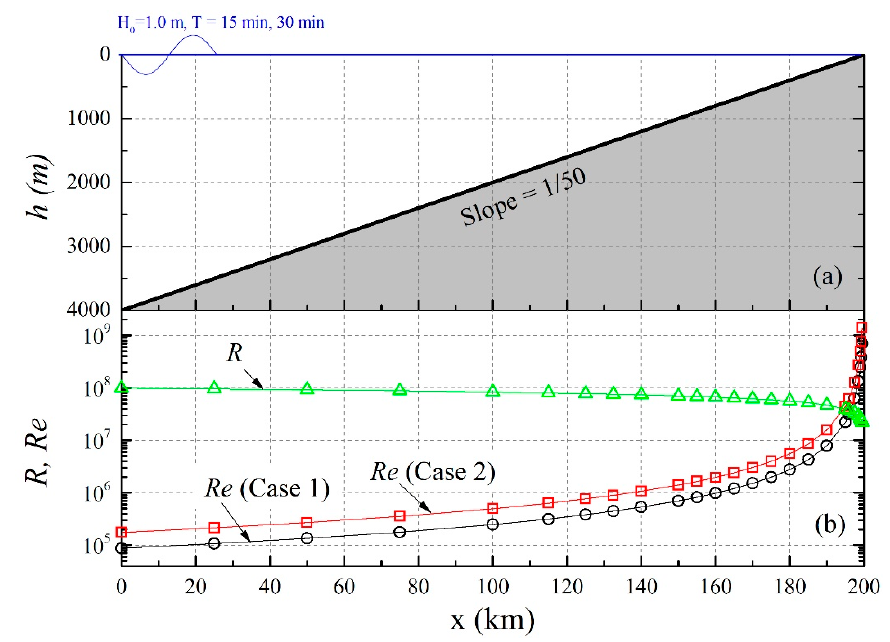
Figure 10. Cross-shore variation of Re and R. Table 4. Input conditions for hypothetical